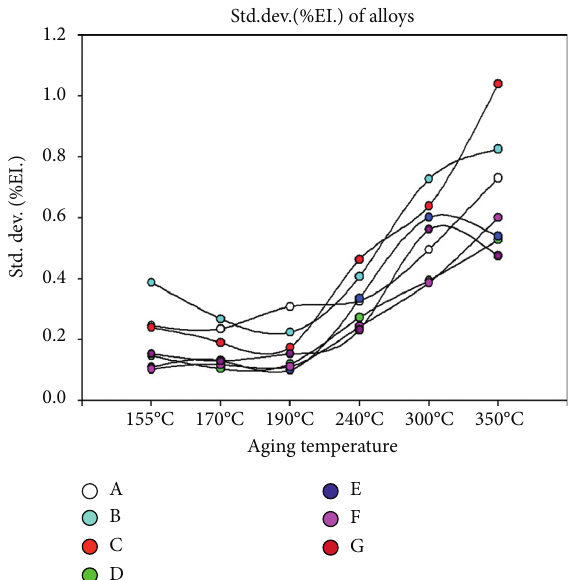
Figure 11: Mean standard deviation of the % elongation values observed for the five alloys and two composites